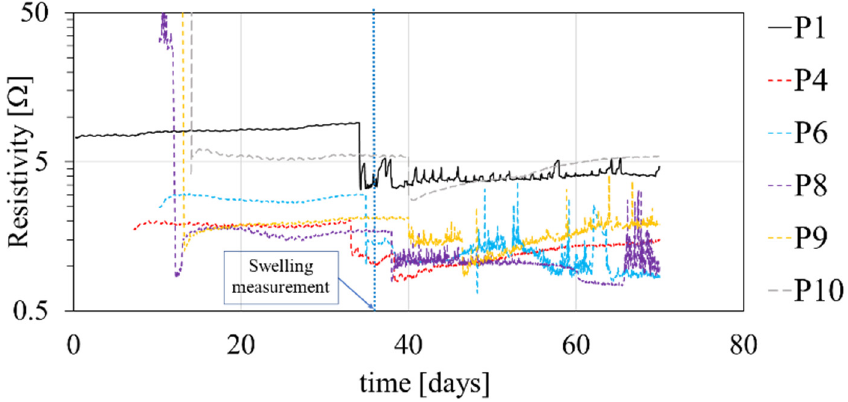
Figure 16. Change in the surface level of the soil during field test.